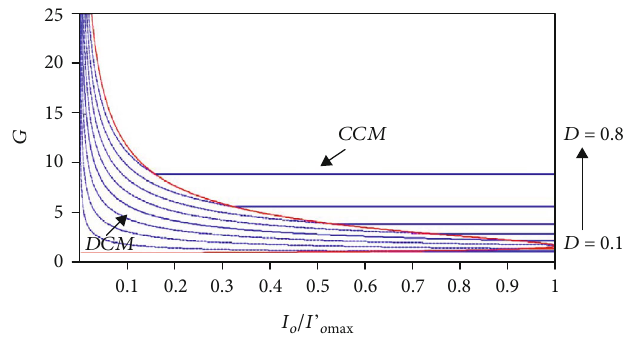
Figure 7: The relationship between duty cycle, current of loads, and gain.